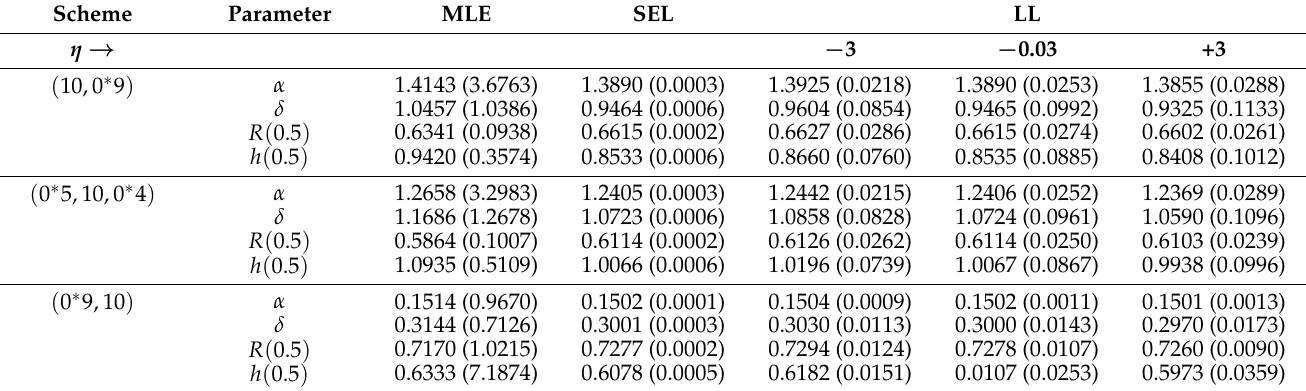
Table 6. The point estimates (SEs) of α , δ , R ( t ) , and h ( t ) using electrical appliances